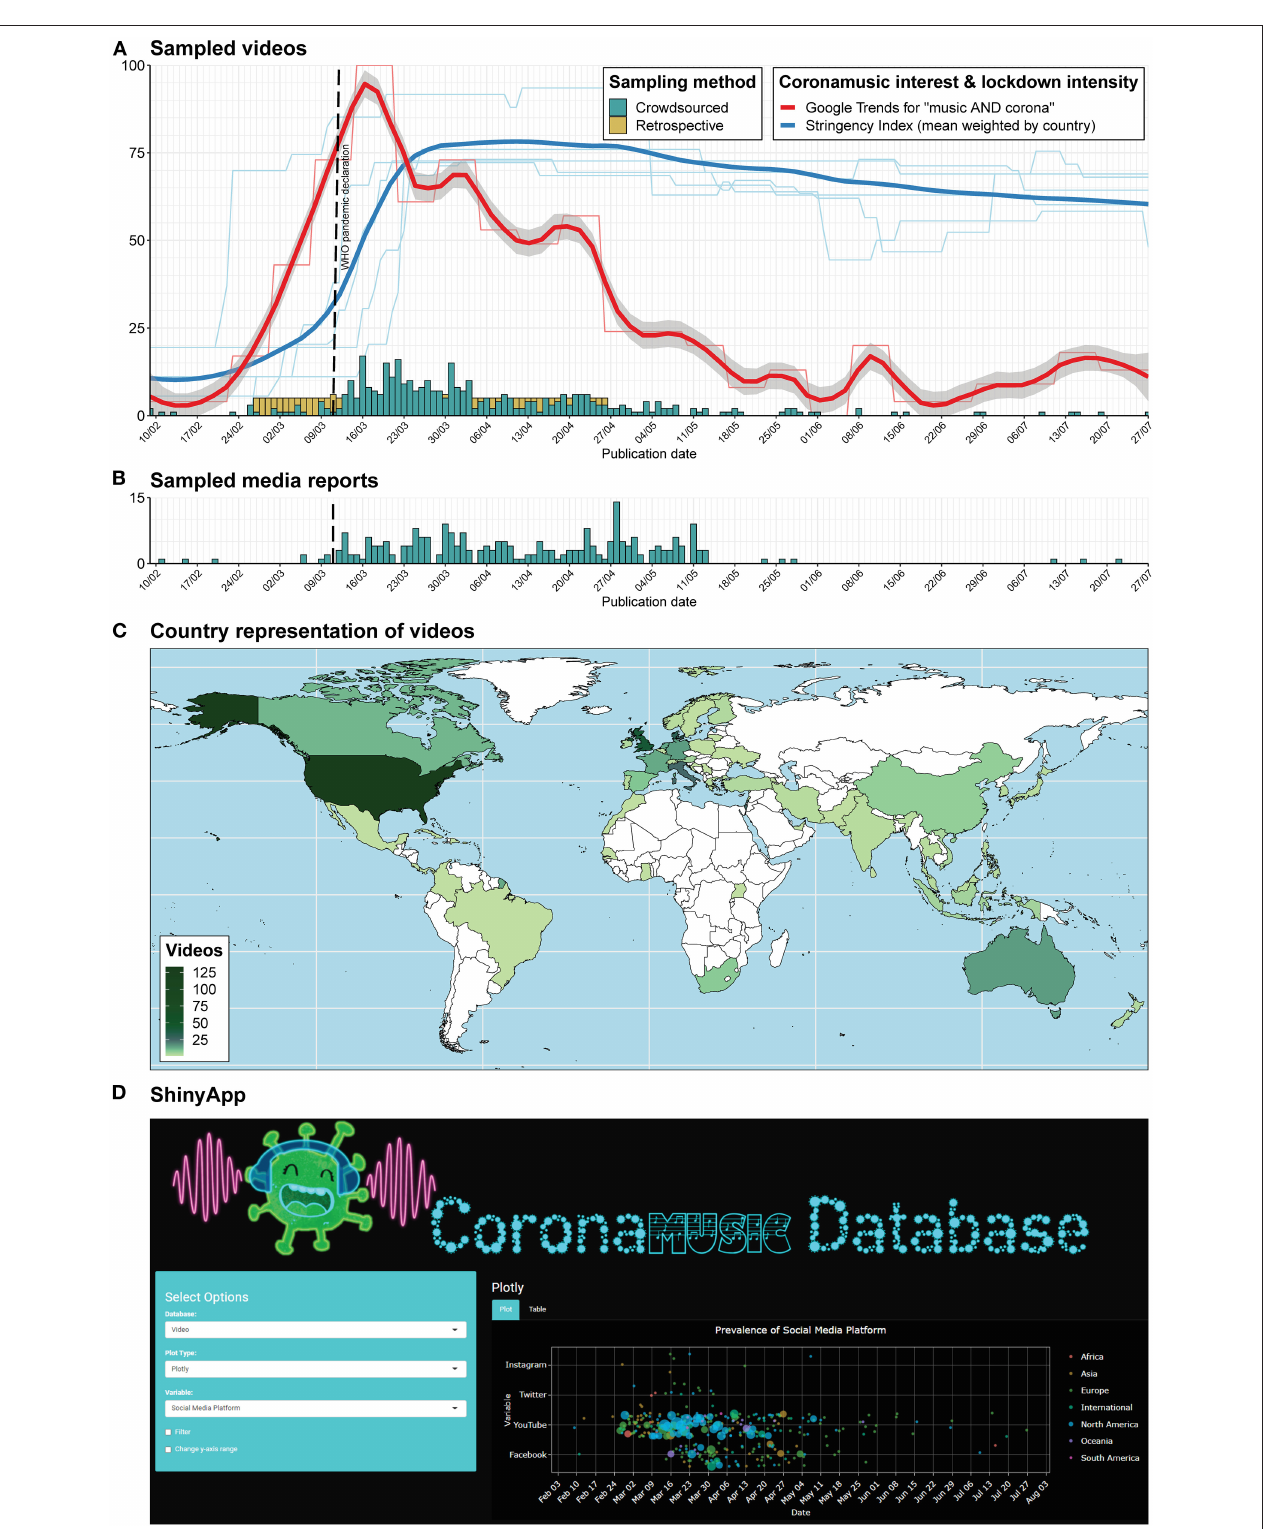
FIGURE 1 | Stacked histograms depicting crowdsourced (turquoise) and retrospectively sampled (yellow) (A) music video and (B) news media content in relation to the time course of coronamusic interest and lockdown intensity in February–July 2020. Coronamusic interest was quantified via weekly Google Trends data for the search term “music AND corona” (thin red line, sourced on 12 February 2021). The thick red line is a LOESS curve (locally estimated scatterplot smoothing) fitted